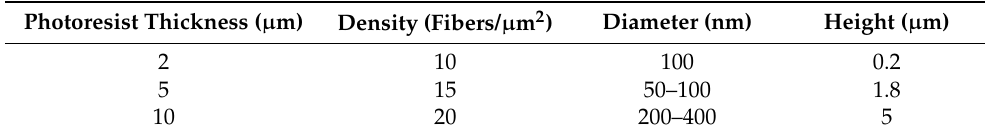
Table 1. The density, diameter, and height of nanoforest structures for different photoresist